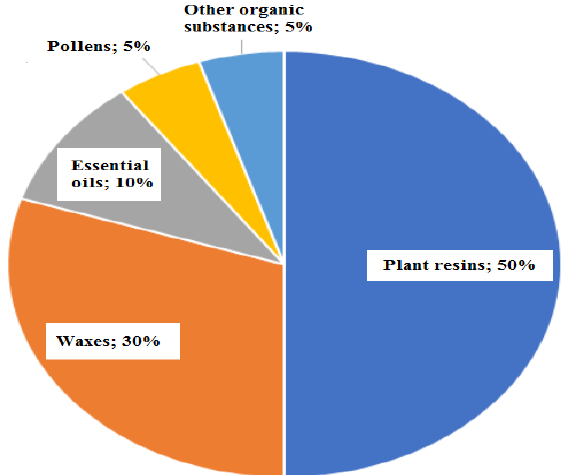
Table 1. Most important propolis types (resumed from [51]).